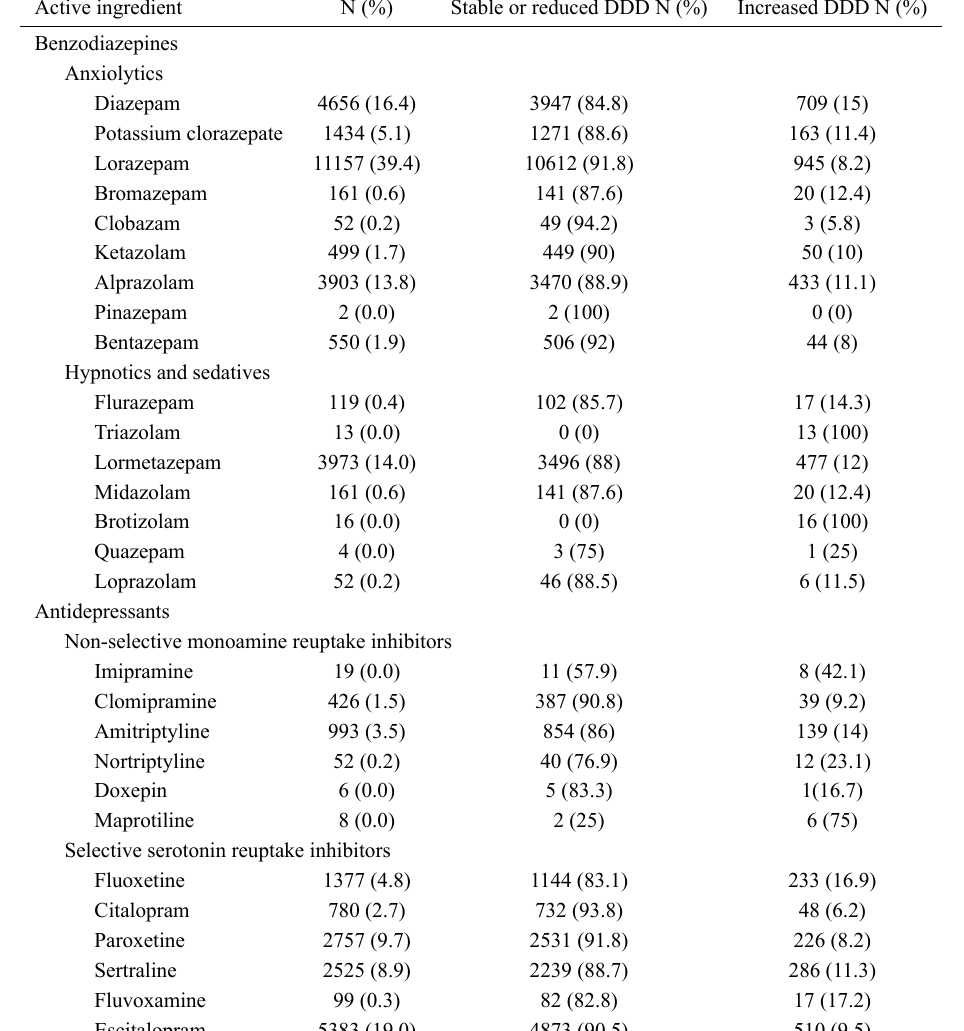
Table 2. Number and percentage of men taking each active ingredient with a stable, reduced or increased